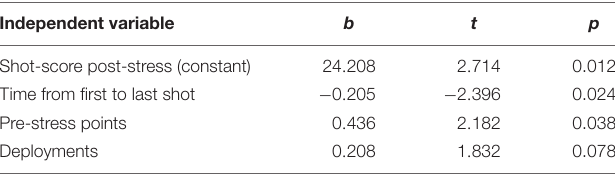
TABLE 5 | Summary of analysis of multiple linear regression for the post-physical stress condition. Independent variable